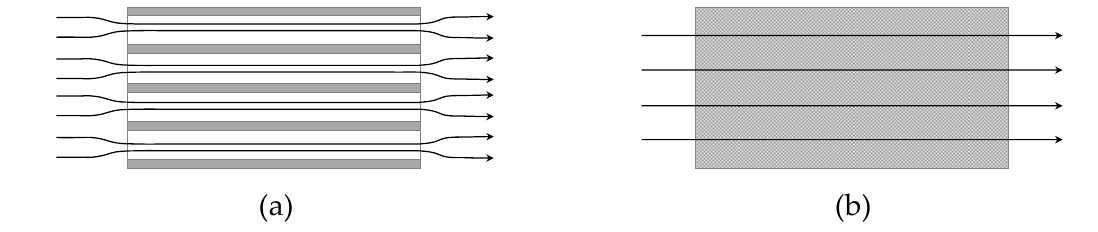
Figure 2. Flow passing through ( a ) a series of channels and ( b ) a homogeneous medium.